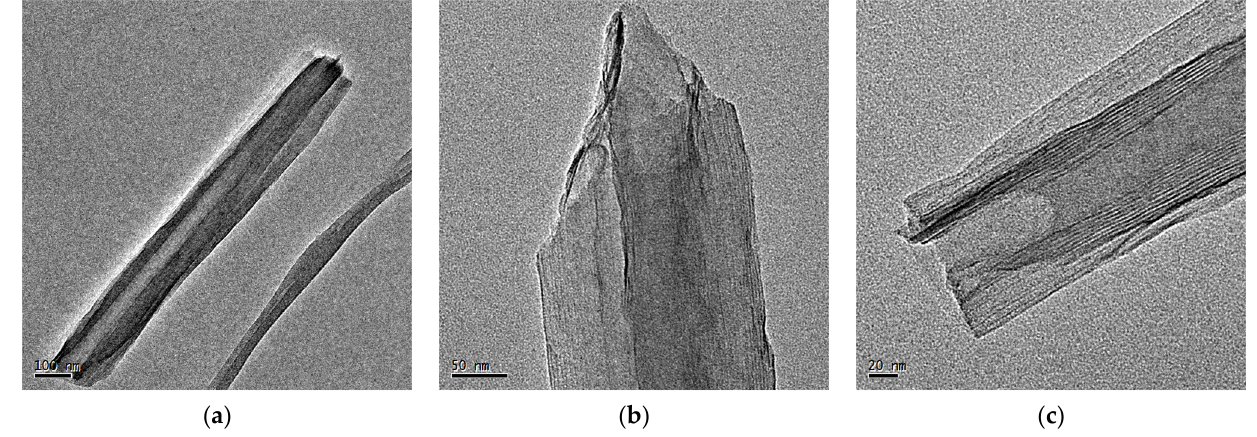
Figure 3. TEM micrographs of vanadium oxide nanotubes VOx-NTs: ( a ) single nanotube exhibits the micrometric, hollow center inner and outer diameter; ( b ) nanotube walls made of V 7 O 162 − lattice embedded with self-assembled long alkyl chain amines; the dark fringes correspond to V 7 O 162 − ; host lattice colorless fringes in-between are associated with the embedded organic amines; and ( c ) tubu- lar open-ended